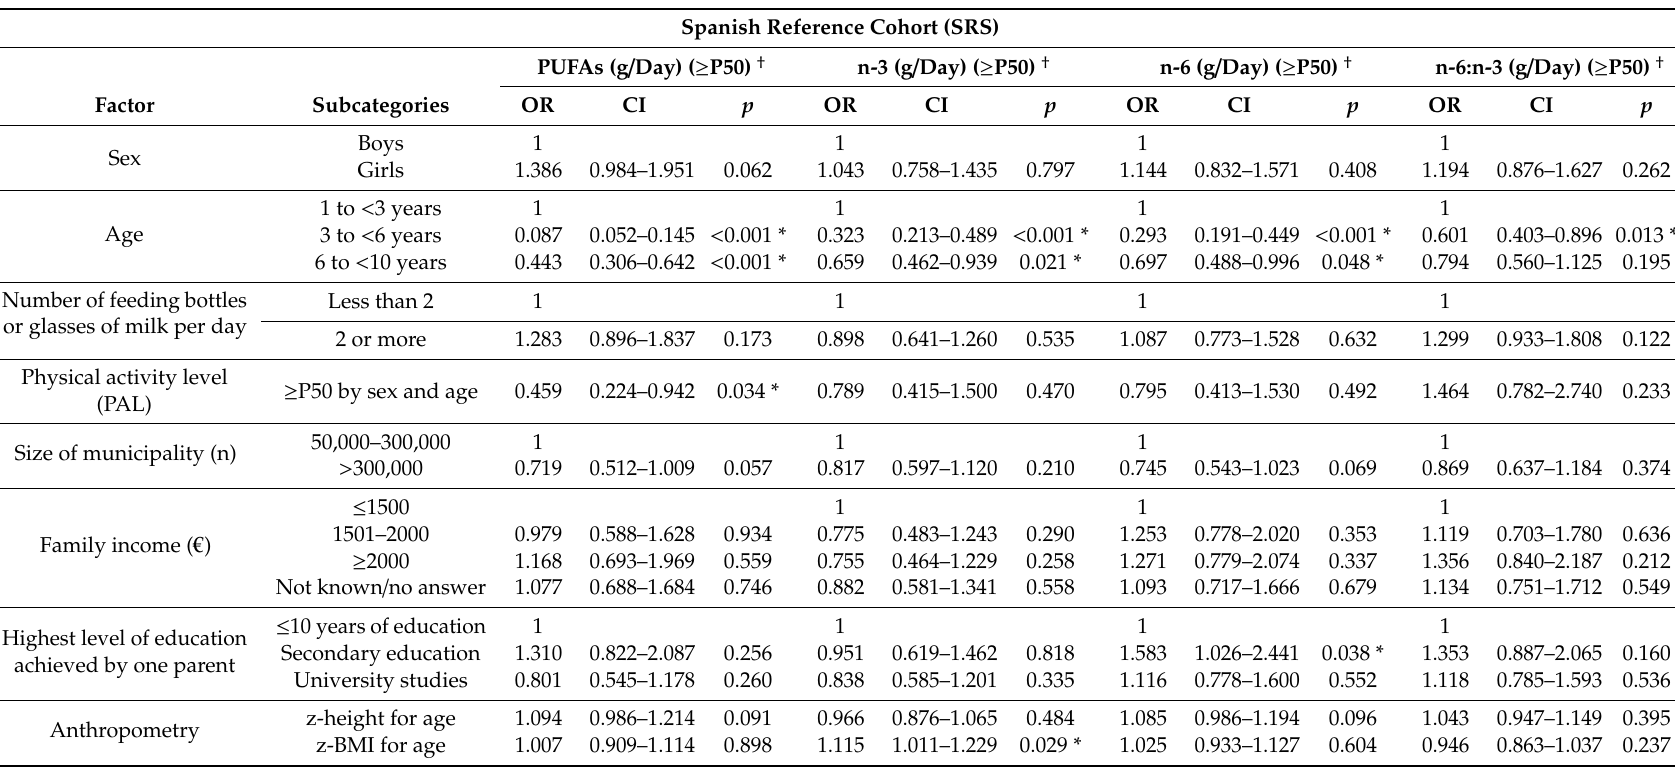
Table 10. Odds ratios and 95% confidence intervals for intake equal to or higher than the median of polyunsaturated fatty acids, n-3 fatty acids, n-6 fatty acids and, n-6:n-3 ratio relative to family and personal factors in the reference cohort of the Nutritional Study in the Spanish Pediatric Population (EsNuPI) ( n =